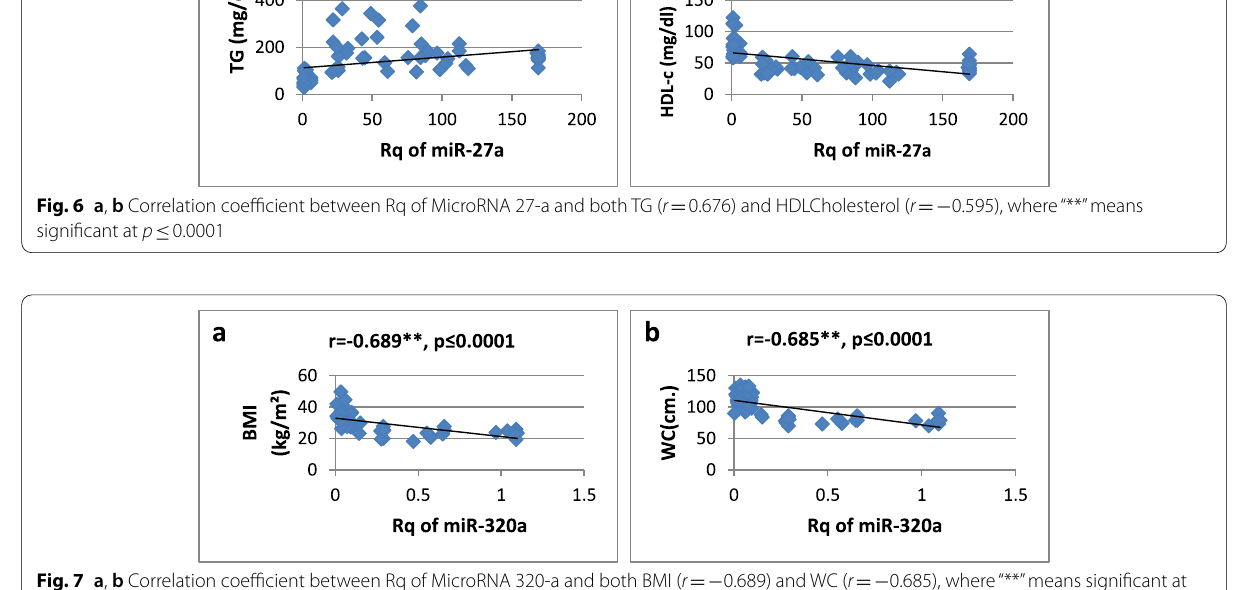
0.689) and WC ( r 0.685), where “**” means significant at = − = −